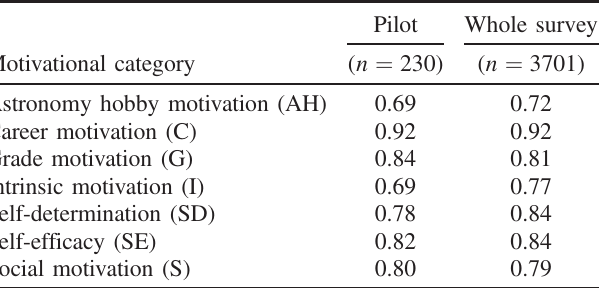
TABLE I. Motivational categories tested by the survey instru- ment. The measure of the instrument ’ s internal consistency — Cronbach ’ s α for the pilot study and the whole dataset is